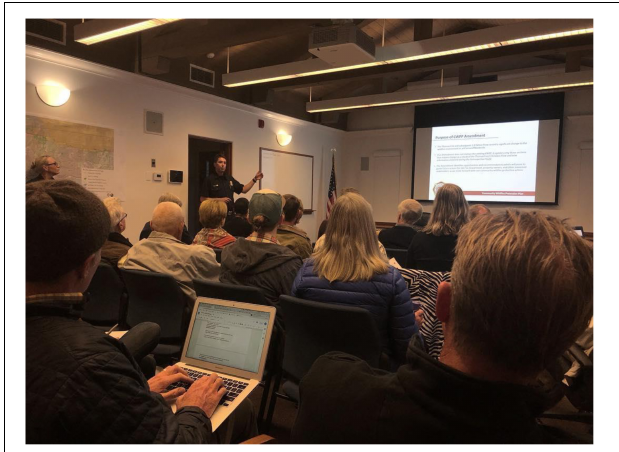
FIGURE 5 | Community members from Montecito, CA, United States, discussing their concerns regarding wildfire with the local Fire Department at a planning meeting. (Credit: Montecito Fire